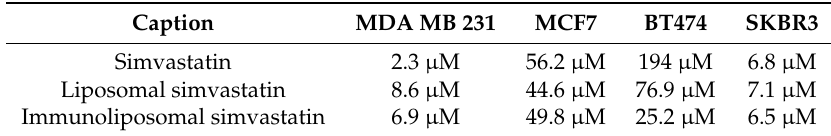
Table 4. IC 50 values for inhibition of cellular viability in breast cancer cell lines after 48 h treatment with free simvastatin and its liposomal and immunoliposomal